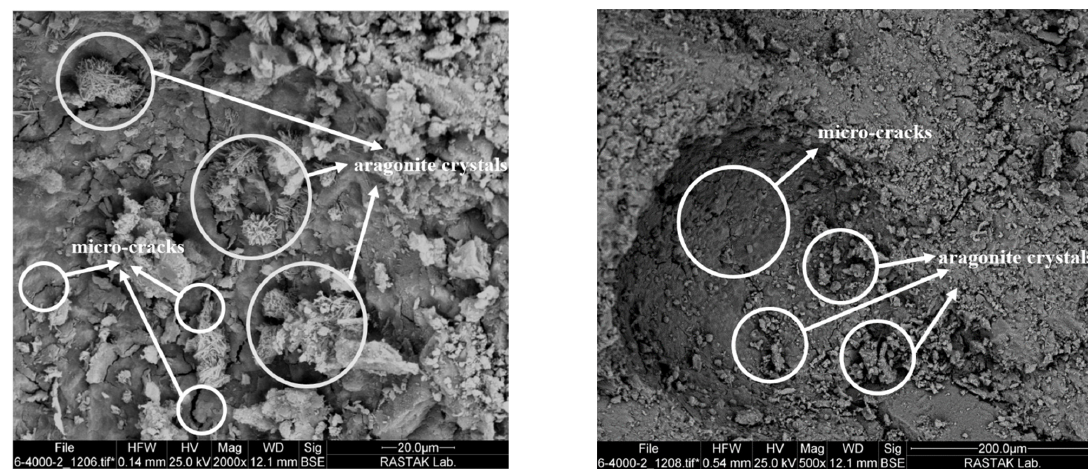
Figure 11. The SEM of concrete specimens repaired by type I bacteria.